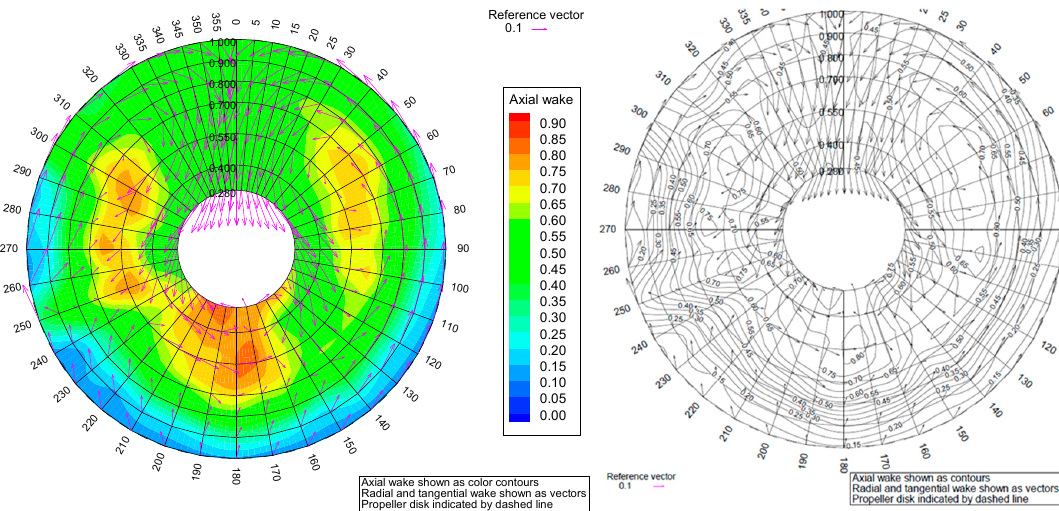
Figure 19. 3D wake measurements at the propeller plane, without PSS, at 14 kn.